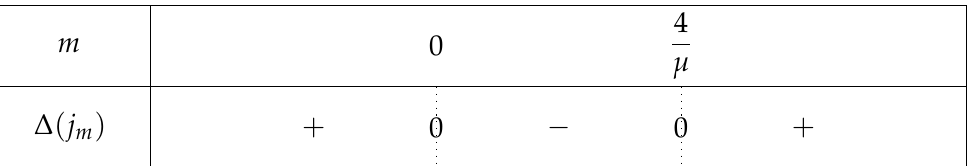
Figure 13. Variation of H m for a (cid:54)